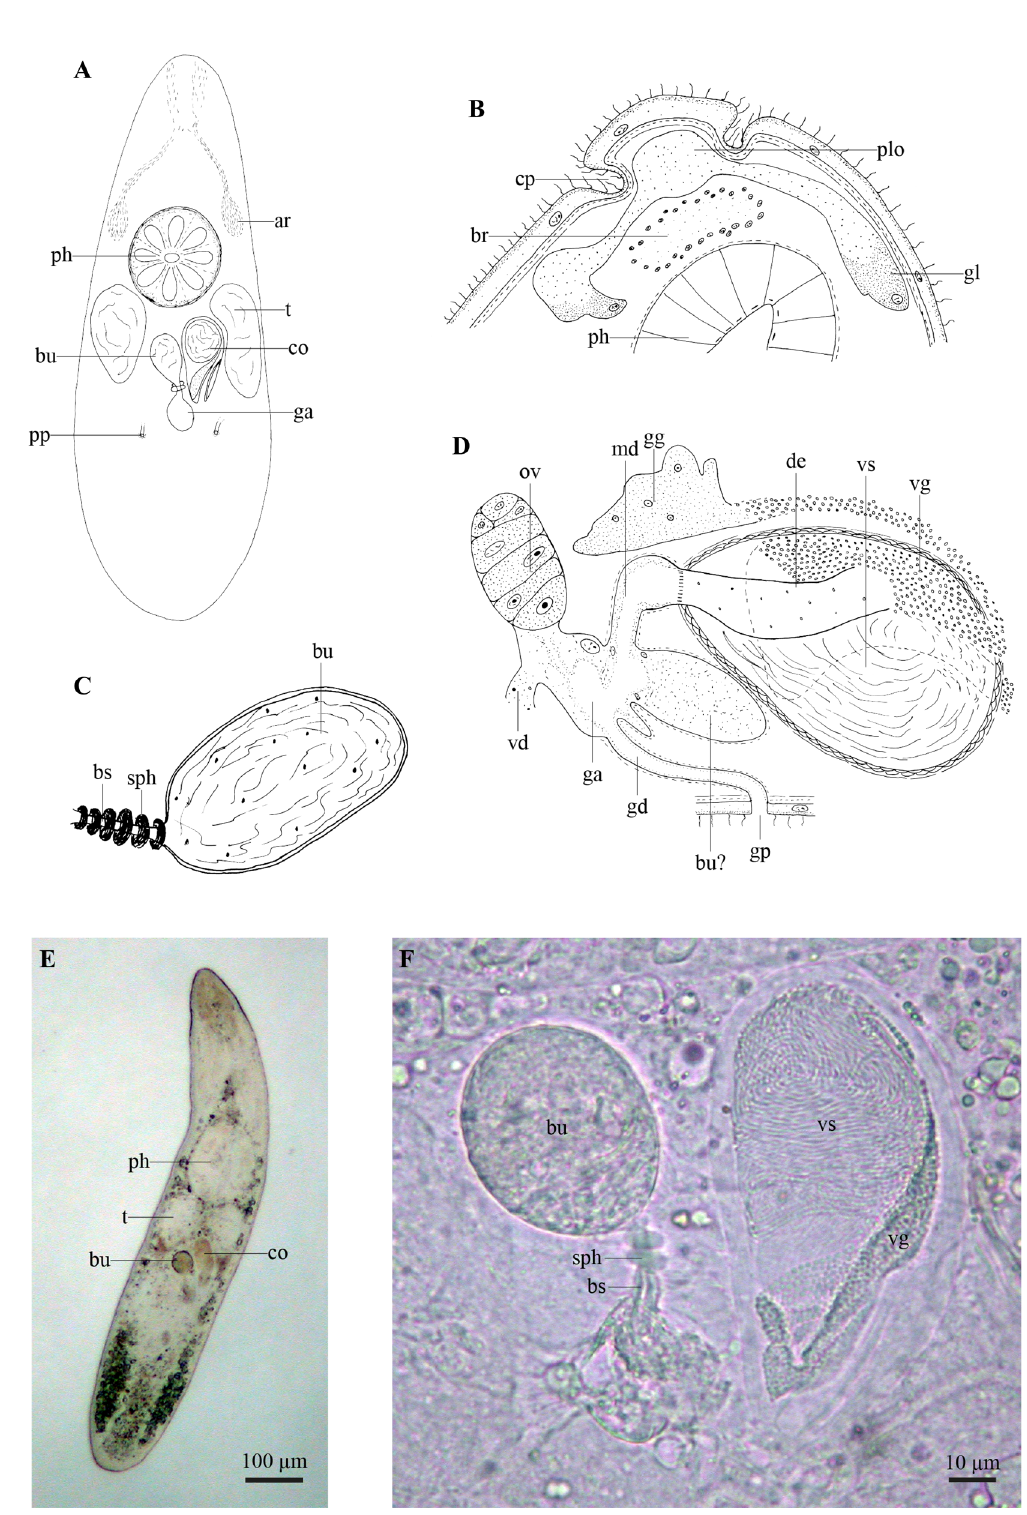
Fig. 10. Prorhynchella minuta Ruebush, 1939. A . Internal organisation of a live specimen. B . Reconstruction of the anterior body part based on horizontal sections. C . Reconstruction of a fully developed bursa based on horizontal sections. D . Reconstruction of reproductive organs based on sagittal sections. E . Squash preparation of a live specimen. F . Detail of the genital system of a live